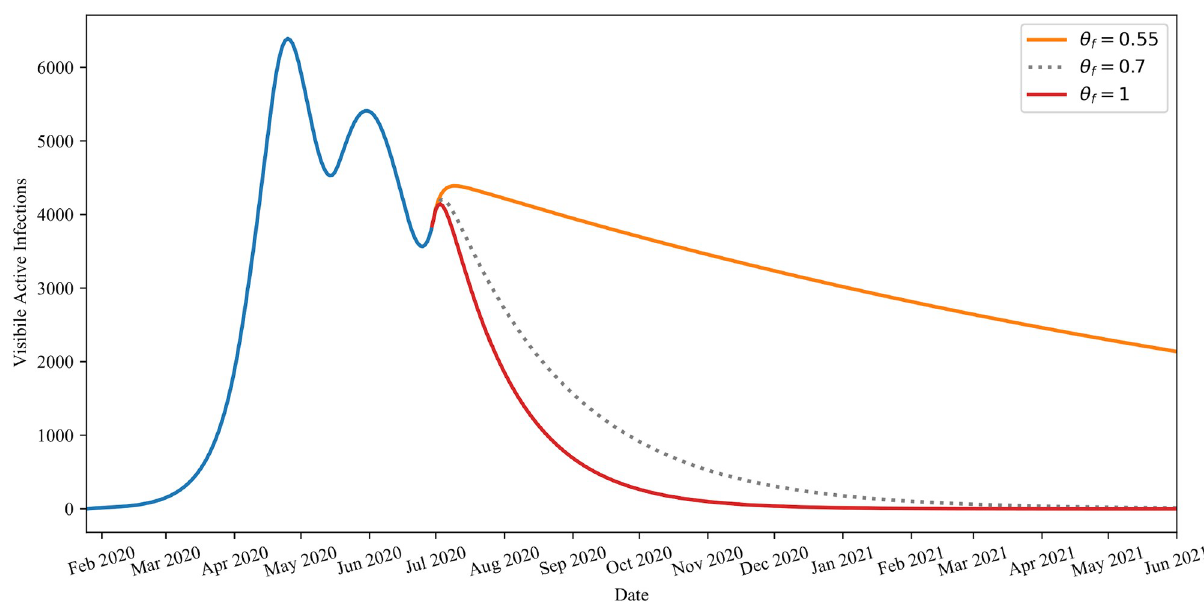
Fig 13. Demonstration of the conditions on I 0 ( t plot demonstrates that no choice of θ prevent I ( t ) from increasing. Moreover, it illustrates that @ θ I 0 ( t ) <